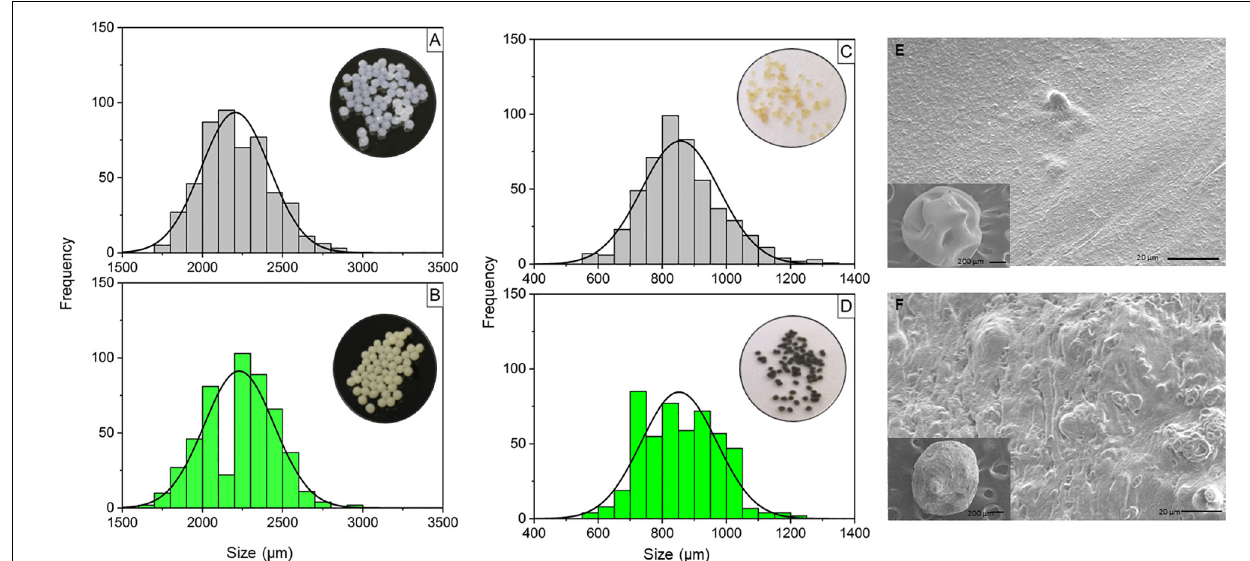
FIGURE 1 | Size distributions of wet and dry calcium alginate microparticles synthesized by ionic gelation, with or without T. harzianum and scanning electron micrographs of the dry calcium alginate microparticles, with and without encapsulated T. harzianum . (A) Wet calcium alginate microparticles; (B) wet calcium alginate/fungus microparticles (1:1 w:w); (C) dry calcium alginate microparticles; (D) dry calcium alginate/fungus microparticles (1:1 w:w). The size distribution was determined using ImageJ software. The wet and dry microparticles presented mean sizes of 2000 and 800 µ m, respectively. (E) Calcium alginate microparticles; (F) calcium alginate:fungus microparticles (1:1 w:w). The interiors of the microparticles with and without the fungus showed differences, due to the presence of the fungus (spores) in the second image. The images were acquired at magnifications of 95 × (insert) and 250 ×